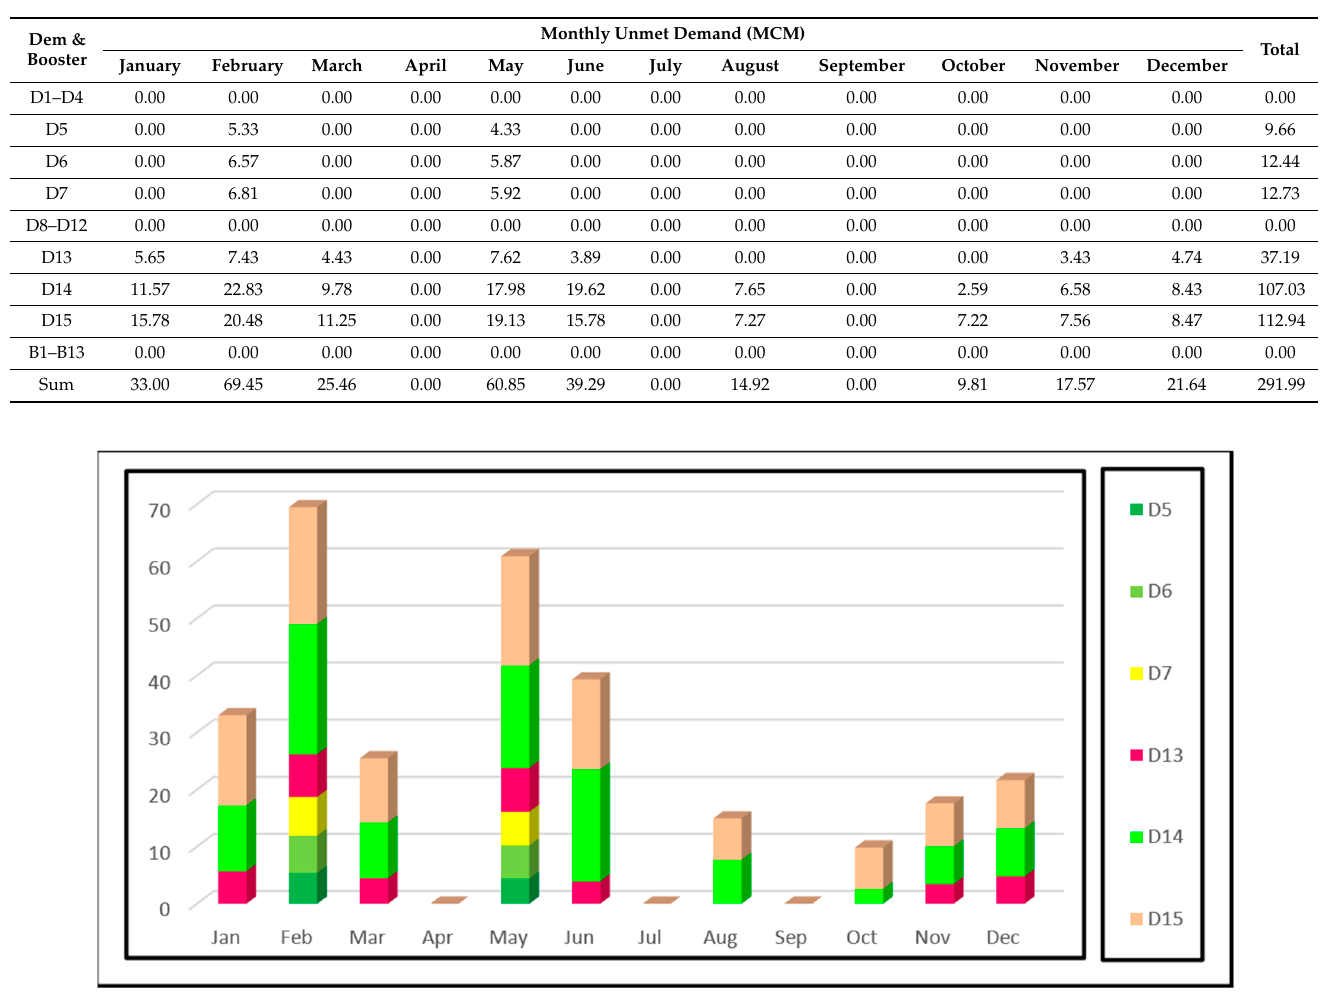
Figure 14. Monthly unmet demand (MCM) of lining three sections.